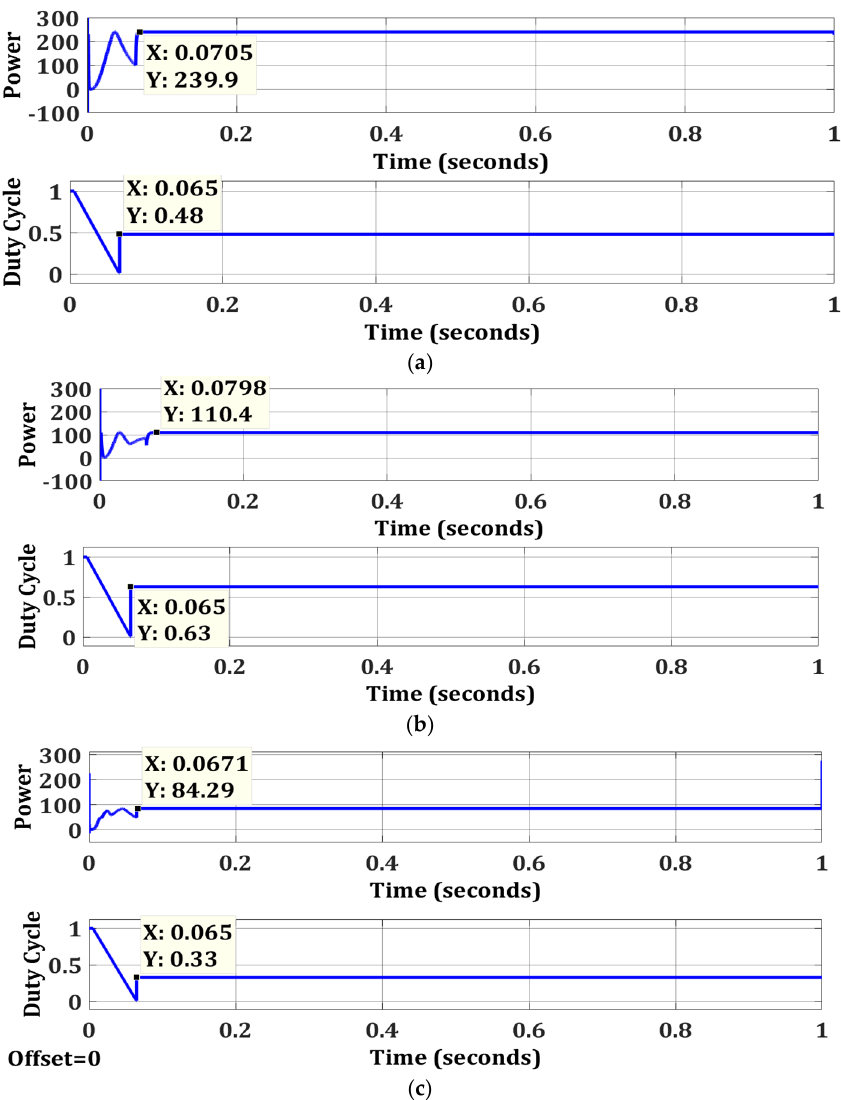
Figure 16. Simulation results for a 4S2P PV system: ( a ) ten check algorithm for test case 1; ( b ) ten check algorithm for test case 2; ( c ) ten check algorithm for test case 3.